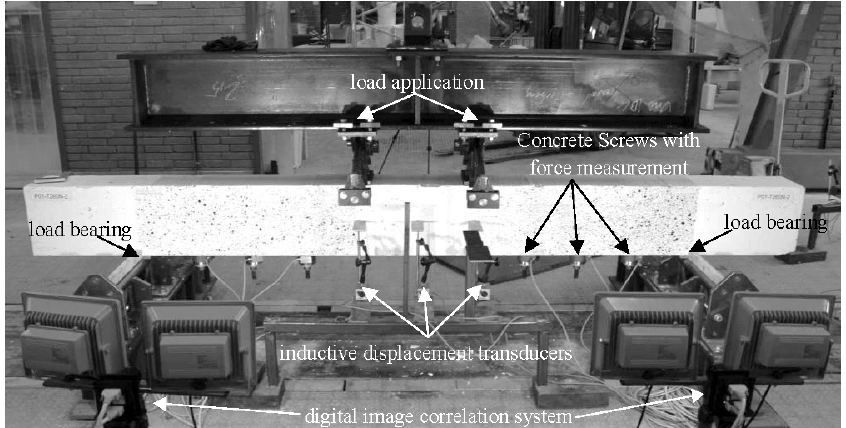
Figure 2. Test setup and measuring systems of the shear tests with concrete screw anchors at the University of